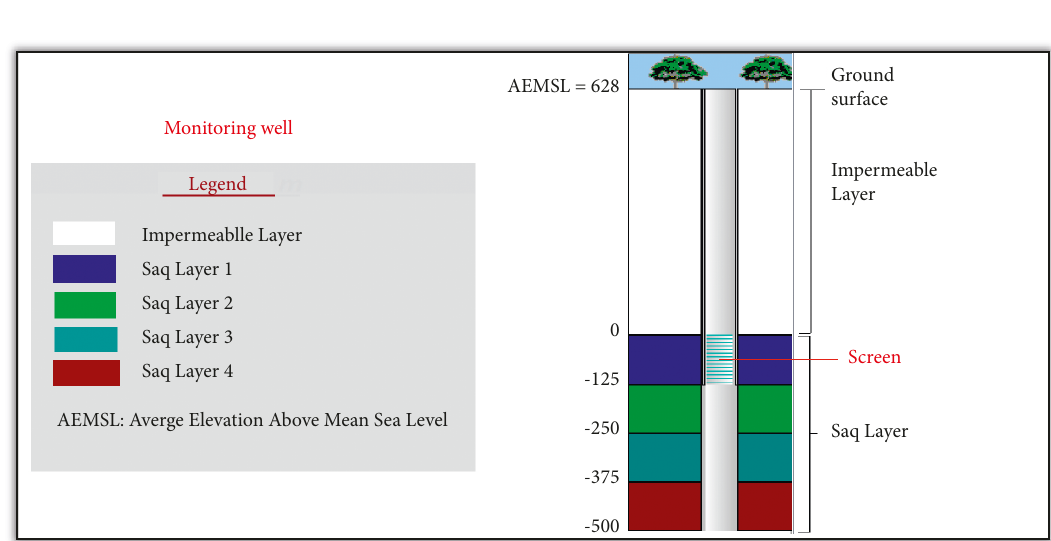
Figure 4: Layers of the Saq Aquifer for MODFLOW models (after Almuhaylan et al.